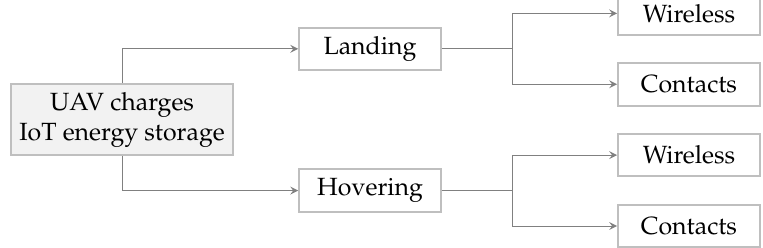
Figure 2. Overview of different subscenarios for IoT charging with